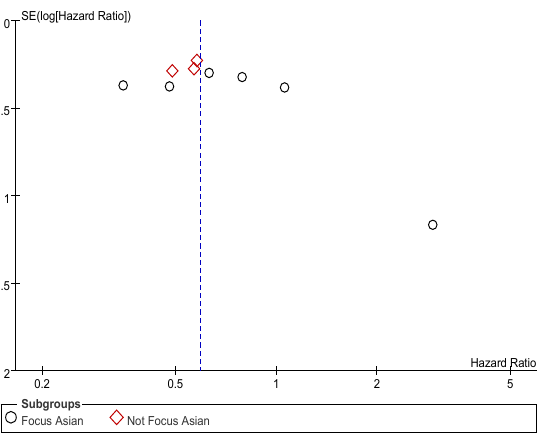
Figure A7. PFS comparisons among ever smoker stratified by ethnicity.